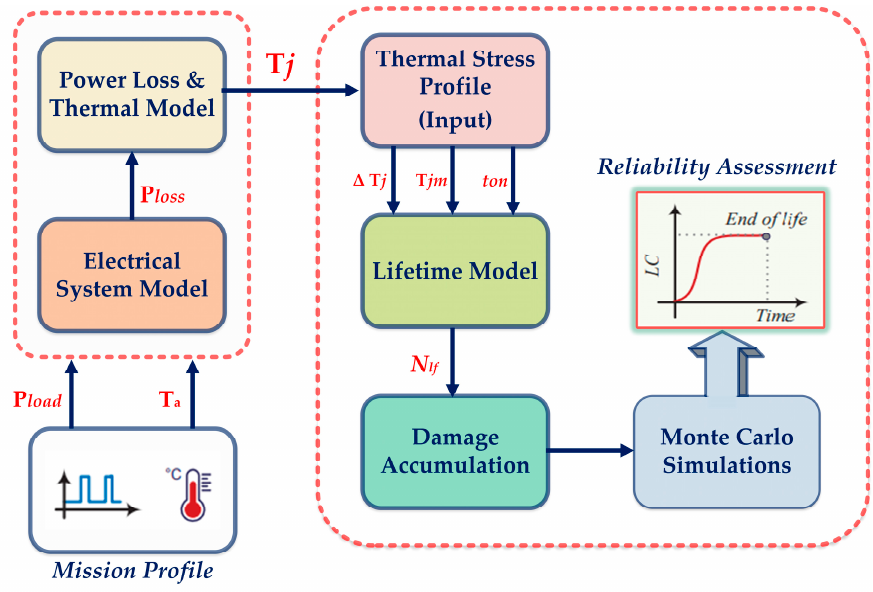
Figure 34. Flow diagram of the Monte Carlo-based reliability assessment of PV inverter.